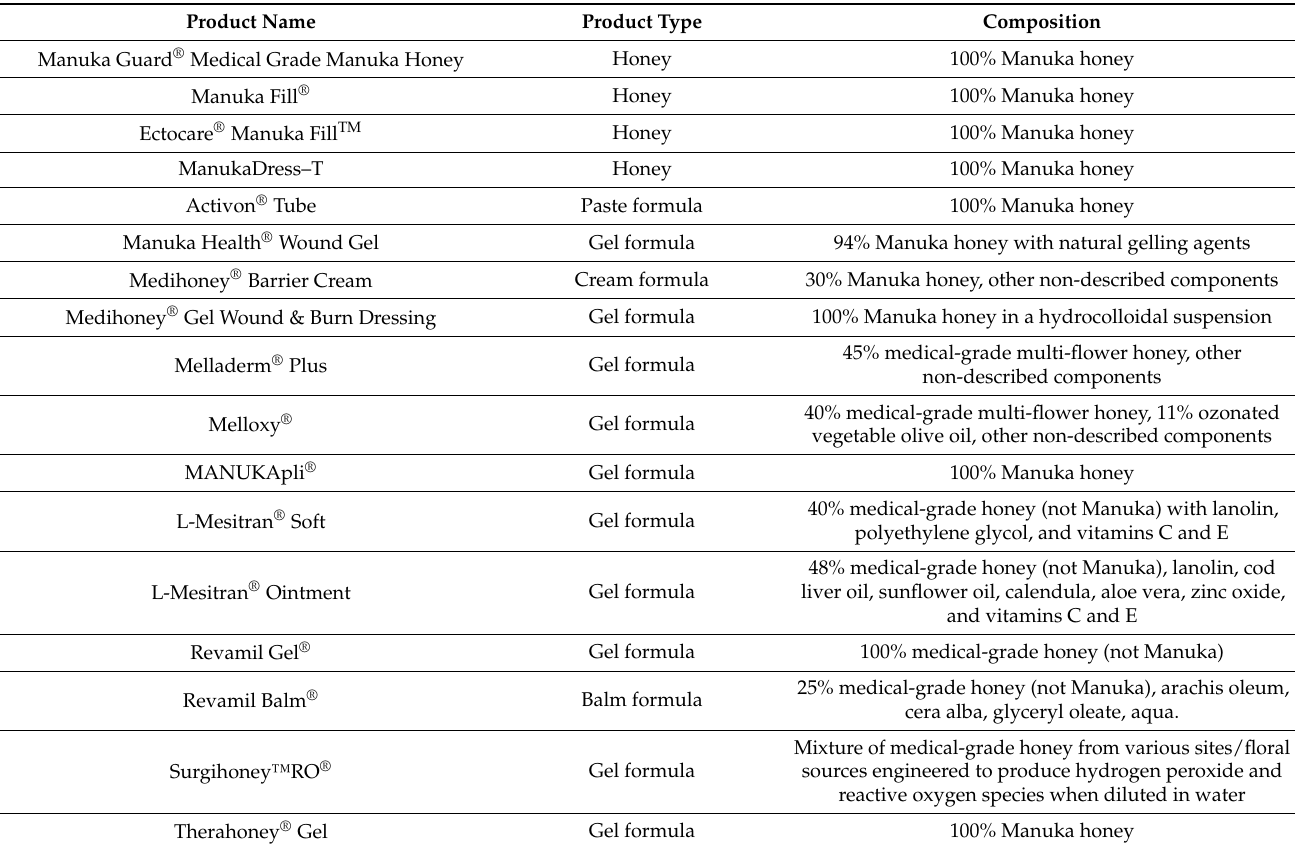
Table 1. Commercially available medical-grade honey and honey-based gels and ointments for wound